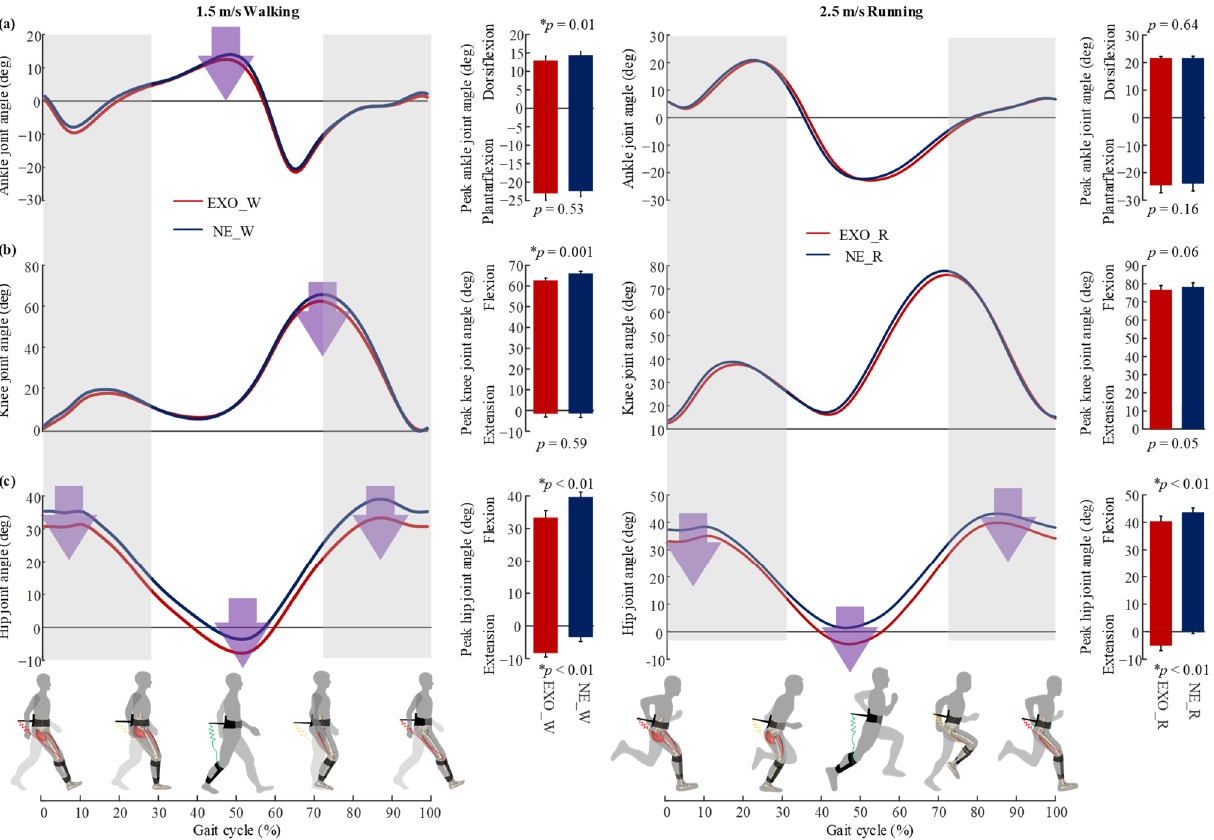
Figure 8. Changes in lower-limb kinematics in walking and running conditions. ( a – c ) The average curves of ankle, knee and hip joint angles across participants over the gait cycle. The bar graphs are the peak flexion and extension angles. The asterisk (*) indicates the statistical difference of peak joint angles between the NE and EXO during walking and running using two-sided paired t -test.